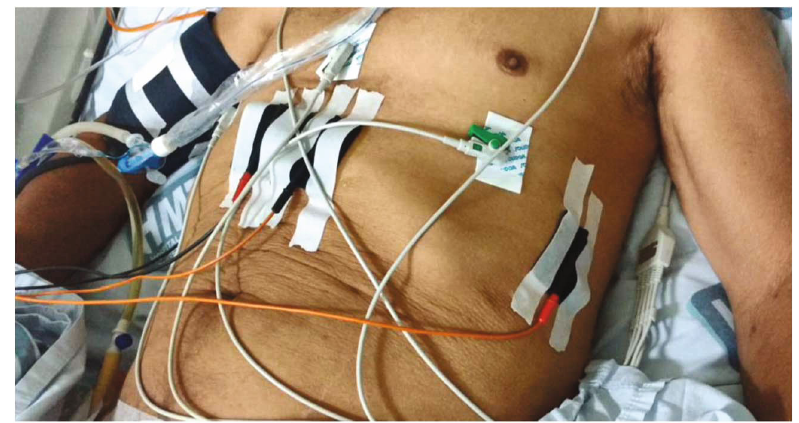
Figure 1: Positioning of the electrodes during transcutaneous electrical diaphragmatic stimulation. Table 1: Characteristics of the studied sample.